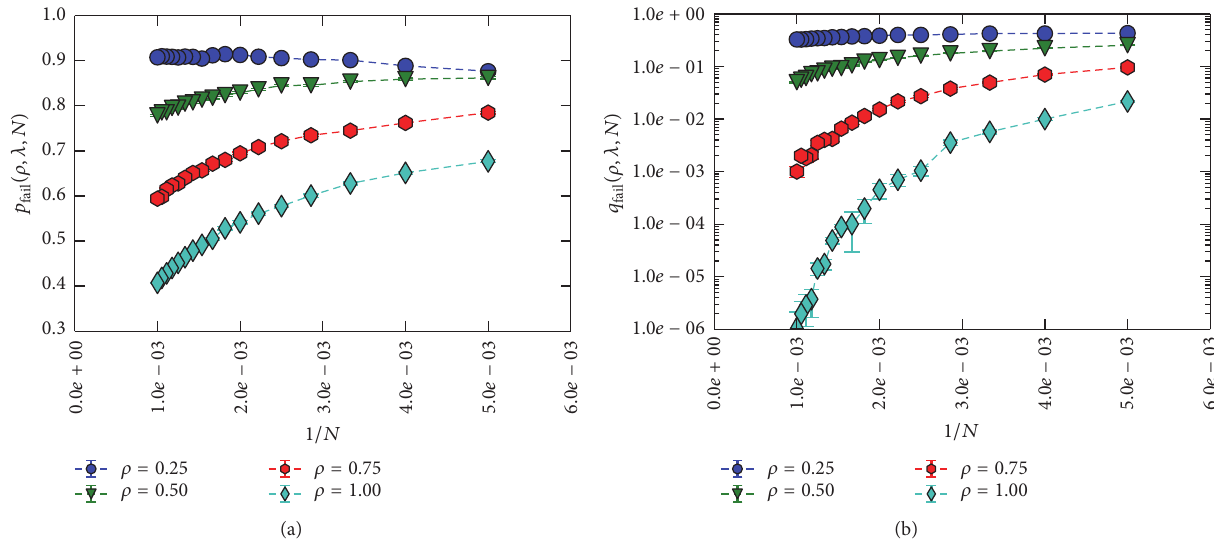
Figure 9: (a) Numerical reconstruction of the failure probability of the iterative procedure as V = 4 and Σ = diag (0.1, 0.3, 0.8, 2.2) , for several values of 𝜌 and for 𝑁 = 200, 250,. .. ,1000 . (b) Failure probability of the perturbative regularization with the same parameters.